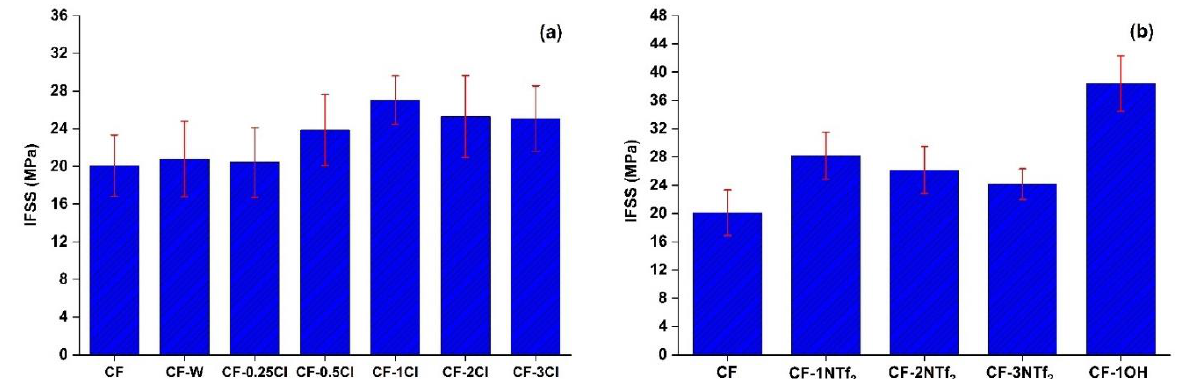
Figure 2. Interfacial shear strength of ( a ) CF, CF-W and CF-Cl (at different concentrations); and ( b ) CF, CF-NTf 2 (at different concentrations) and CF-1OH.